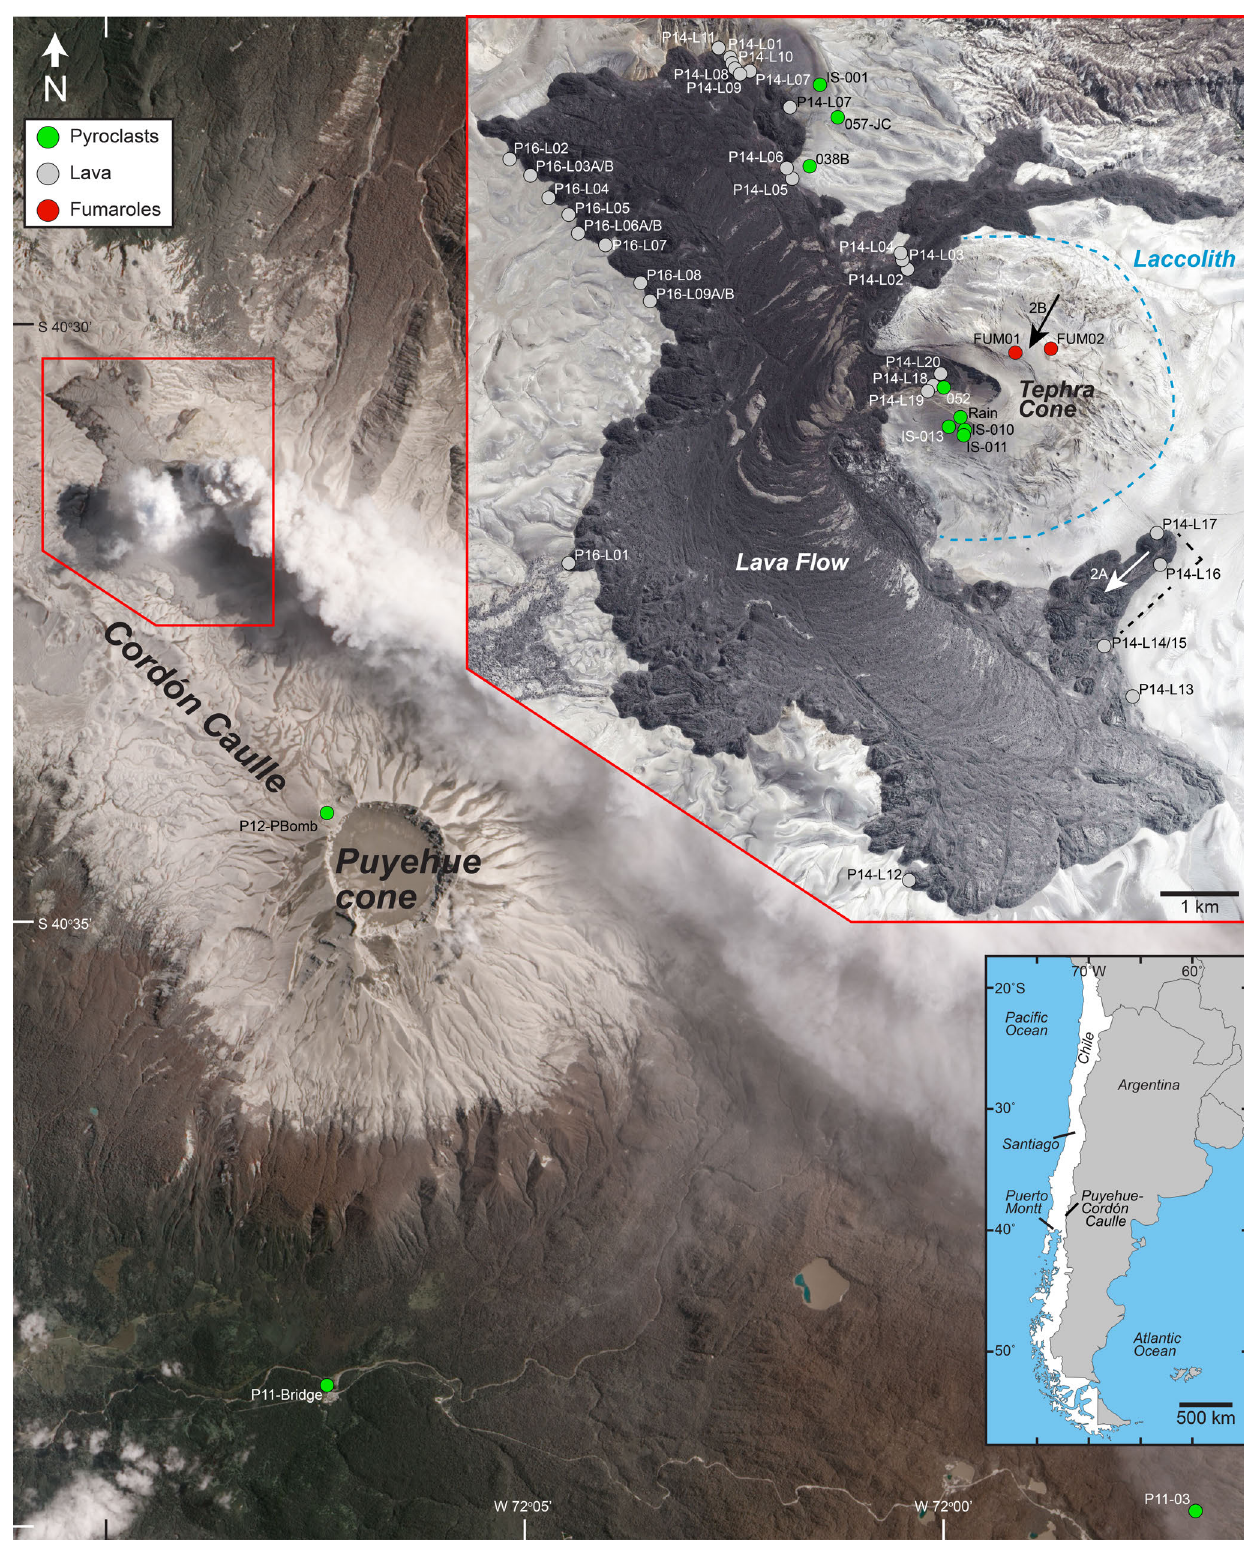
Figure 1: Location and samples. Main image was taken by the Advanced Land Imager on NASA’s Earth Observing-1 (EO-1) satellite on January 26, 2012. Inset of 2011–2012 eruptive features and deposits is from Google (2017, DigitalGlobe), with approximate extent of the laccolith indicated by blue dashed line [Castro et al. 2016]. Arrows indicate view directions shown in Figure 2. Inset map shows location of Puyehue–Cordón Caulle in southern